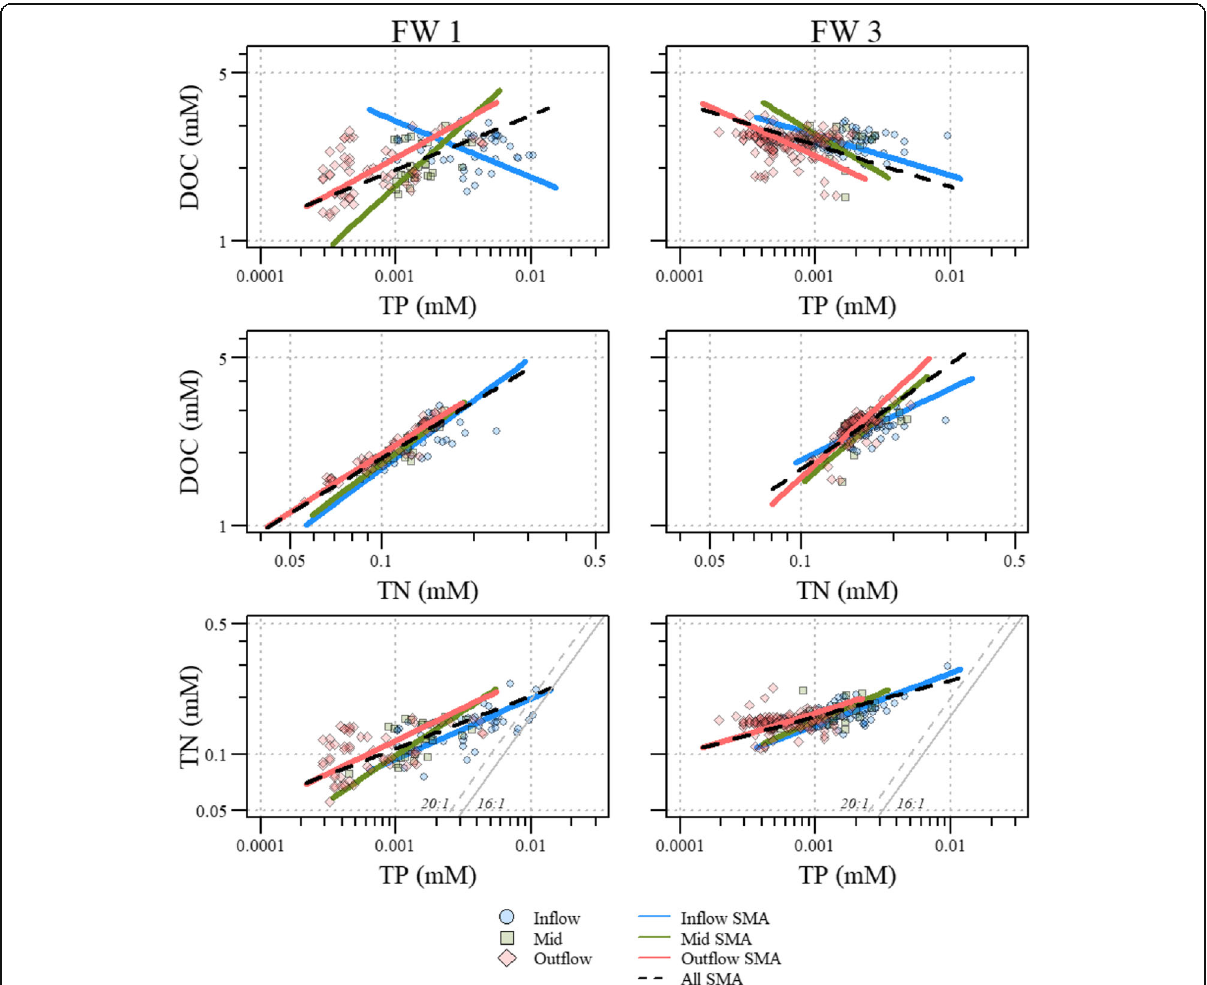
Fig. 3 Stoichiometric relationships between dissolved organic carbon (DOC), total phosphorus (TP), and total nitrogen (TN) in the surface water ecosystem compartment for Stormwater Treatment Area 2, flow-ways (FWs) 1 and 3. Inflow, mid, outflow, and overall standardized major axis (SMA) regressions are indicated by lines through the data. Values can be converted to mass per volume (i.e., milligram per liter) concentration by multiplying each value by its respective conversion factor (C = 12.01; N = 14.00; P =